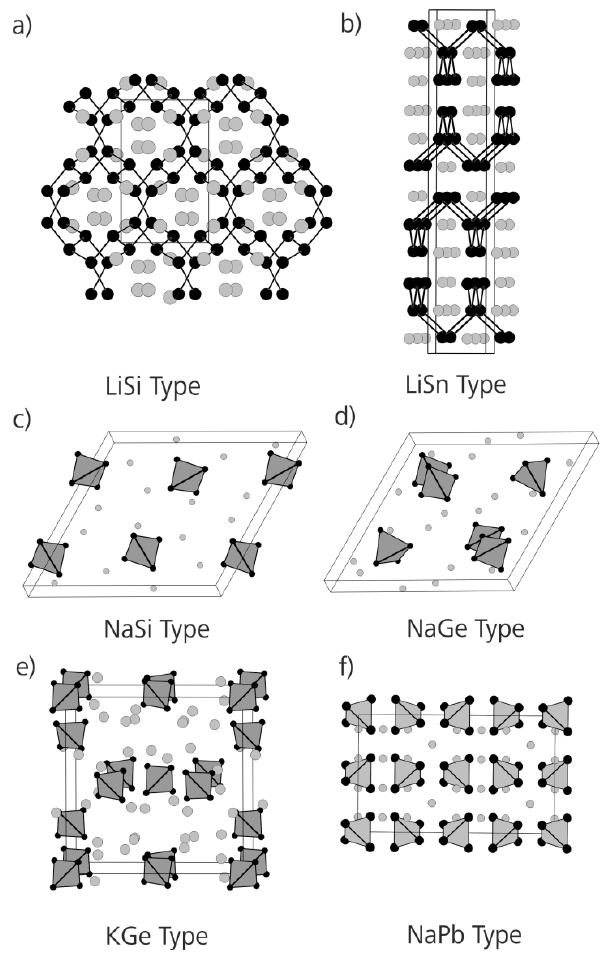
Figure 1. Different structure types for the binary phases of alkali metal (Li-Cs) and group 14 element with 1:1 stoichiometric ratio (ambient conditions) ( a – f ). Table 2. Hitherto known A 4 E 4 · x NH 3 (A = Li-Cs; E = Si-Pb) solvate structures and selected crystal structure details. The bold marked new compounds are discussed in this article.